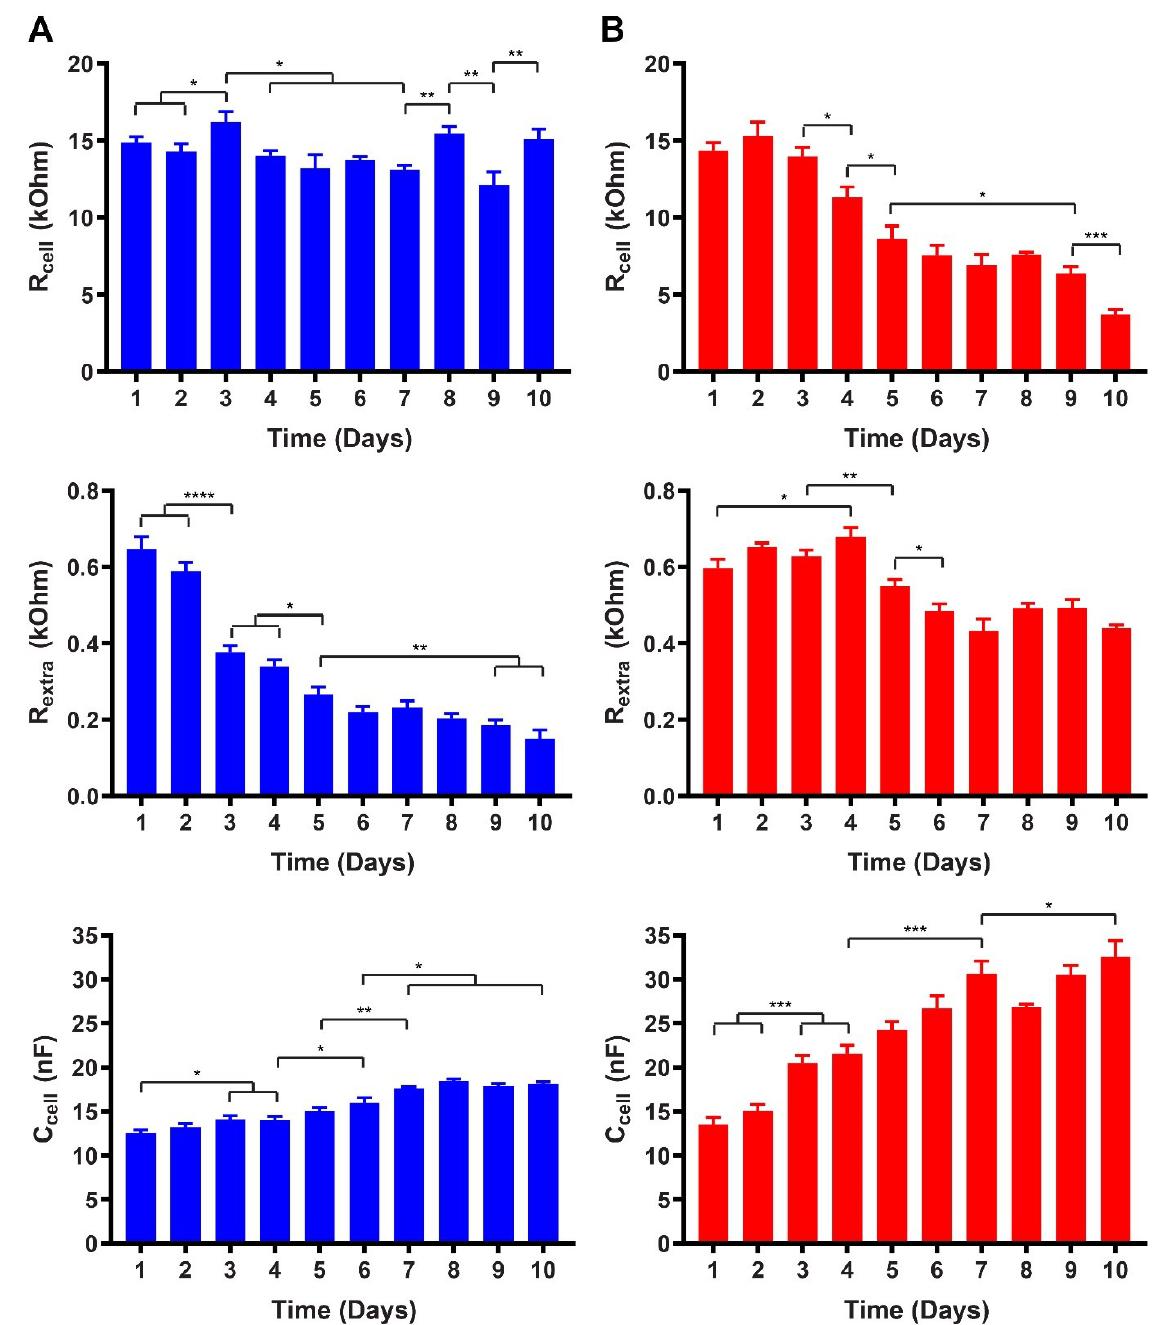
Figure 9. Summary of the cell specific equivalent circuit components (R cell , R extra , C cell ) for A ) proliferating and B ) differentiating hVM1 Bcl-X L cells (seeding density: 120,000 cells/cm 2 ). Time in days after cell seeding. (Error bars: s.e.m., n =